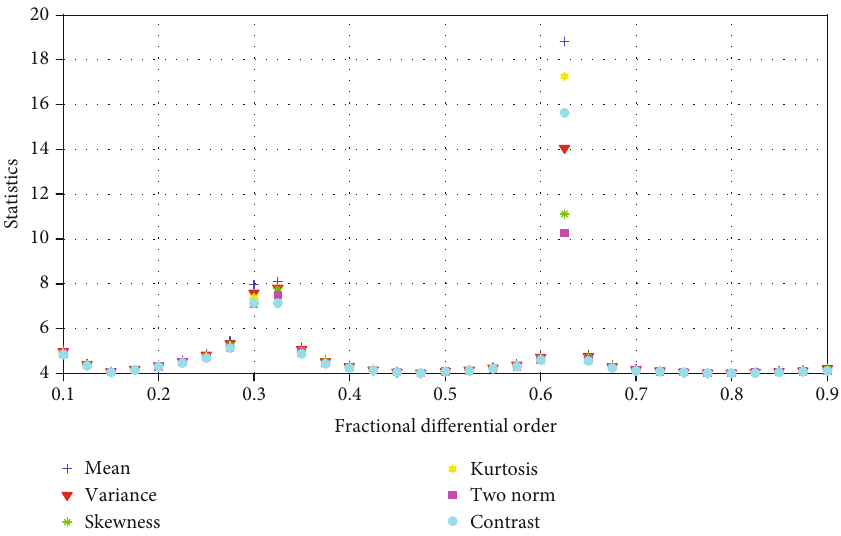
Figure 3: Scatter plot of fractional di ff erential order and various